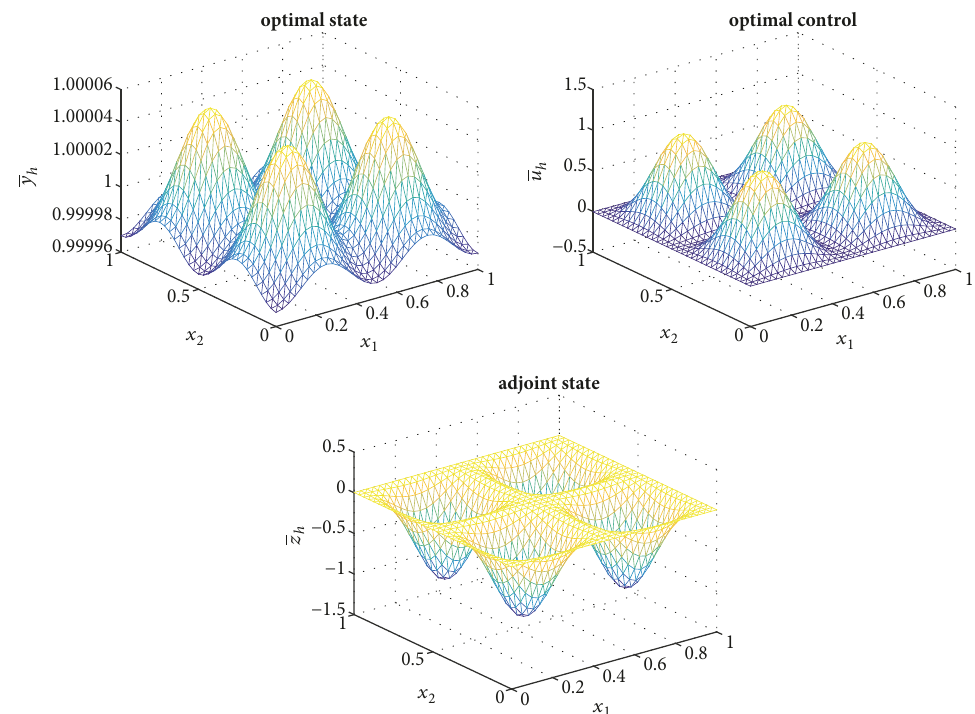
Figure 3: Numerical results of Experiment 1: optimal state, optimal control, and corresponding adjoint state.